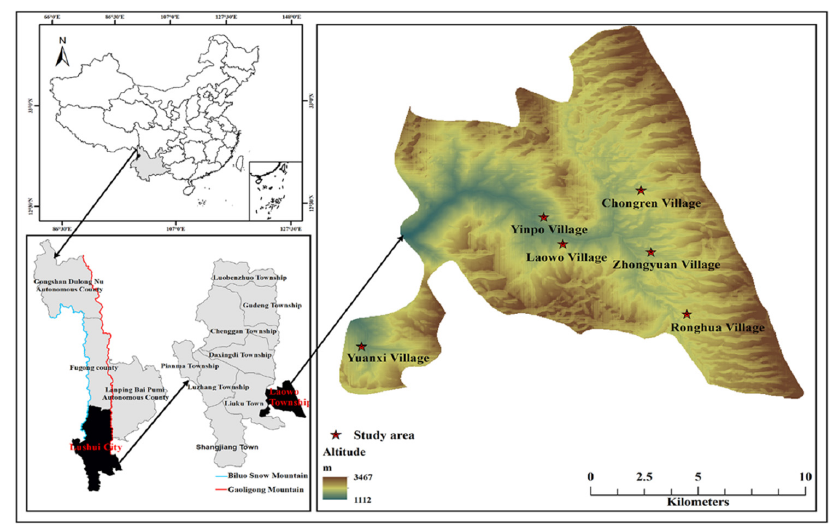
Figure 1. Map of the study area.